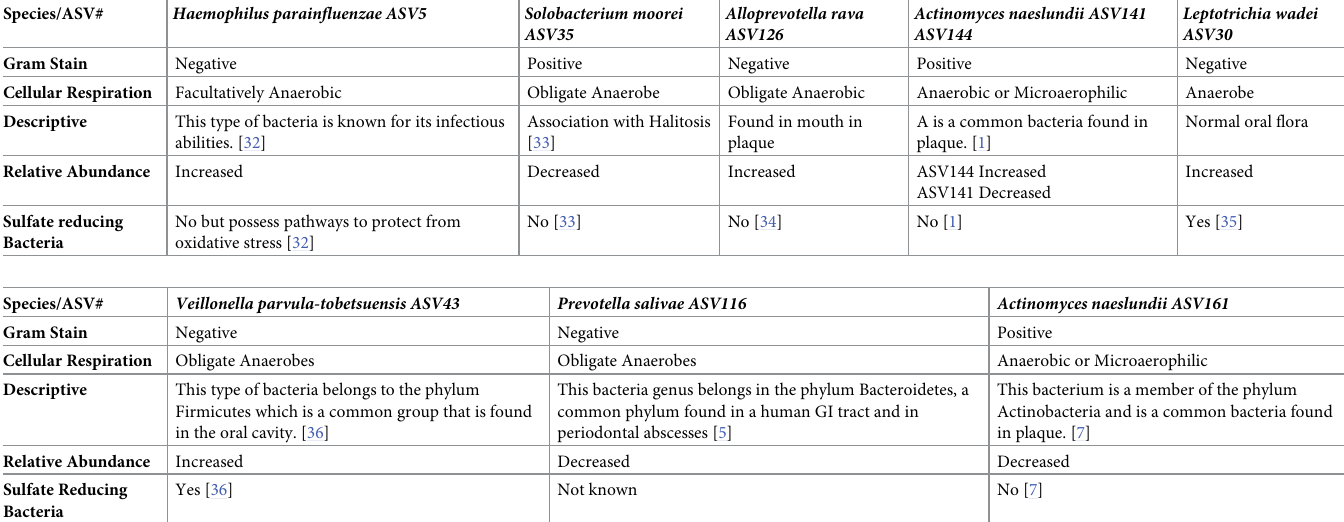
Table 2. A: Bacteria species/ASVs exhibiting a significant change in relative abundance after exposure to sodium sulfite. B: Bacteria species/ASVs exhibiting a signifi- cant change in relative abundance after exposure to sodium bisulfite. Species/ASV# Haemophilus parainfluenzae ASV5 Solobacterium moorei